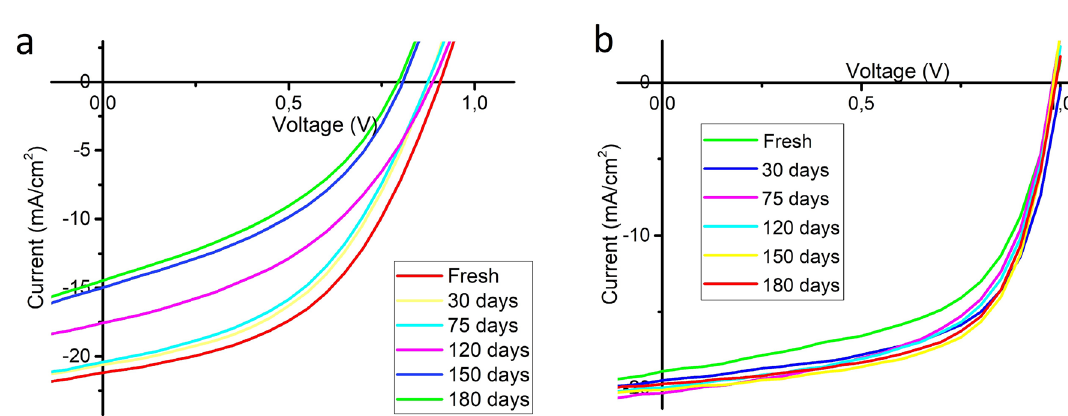
Figure 5. IV graph of ( a ) reference ( b ) sepiolite included PSCs for 6